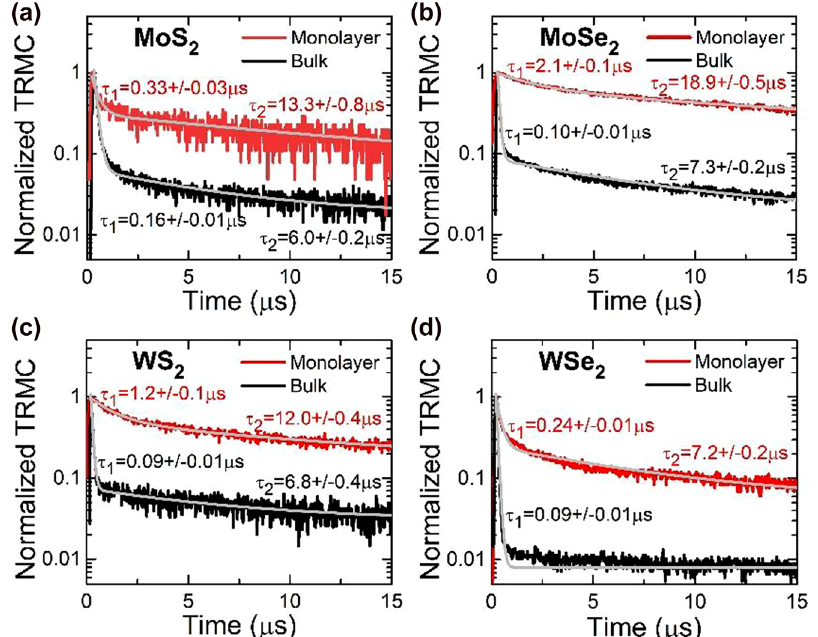
Figure 2: Normalized transient signal of monolayer (red curves) and bulk (black curves) TMDs obtained at room temperature. The gray lines represent the fits with bi-exponential